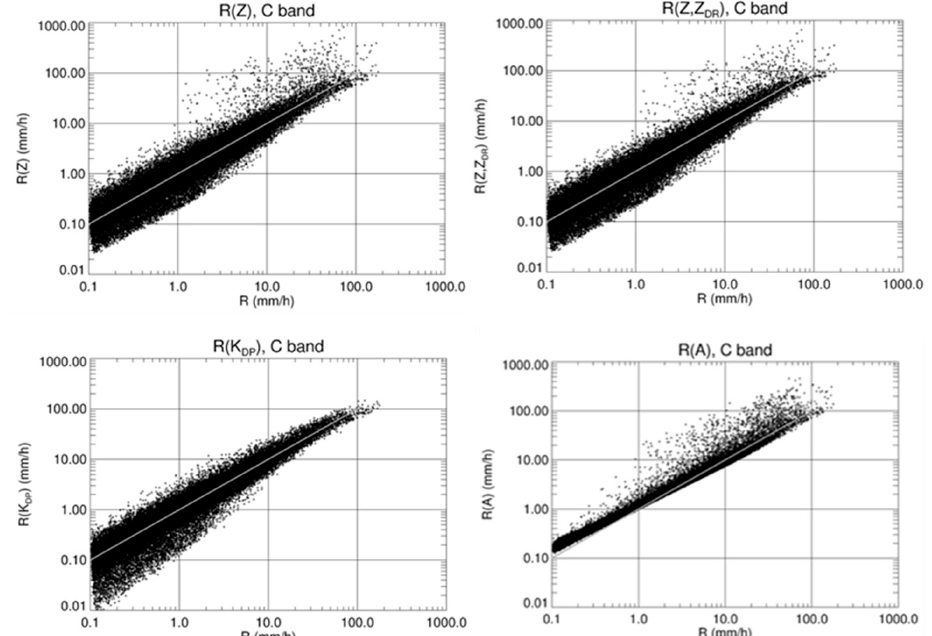
Figure 2. Scatterplots of rain rates versus their estimates from relations R ( Z ) = 1.77 10 − 2 Z 0.712 , R ( Z , Z DR ) = 1.70 10 − 2 Z 0.731 Z − 0.459 , R ( K DP ) = 25.3 K 0.776 , and R ( A ) = 294 A 0.89 optimized for DP dr Oklahoma DSD dataset at C band ( λ = 5.3 cm) and T = 20 ◦ C. Z and Z DR are in a linear scale.